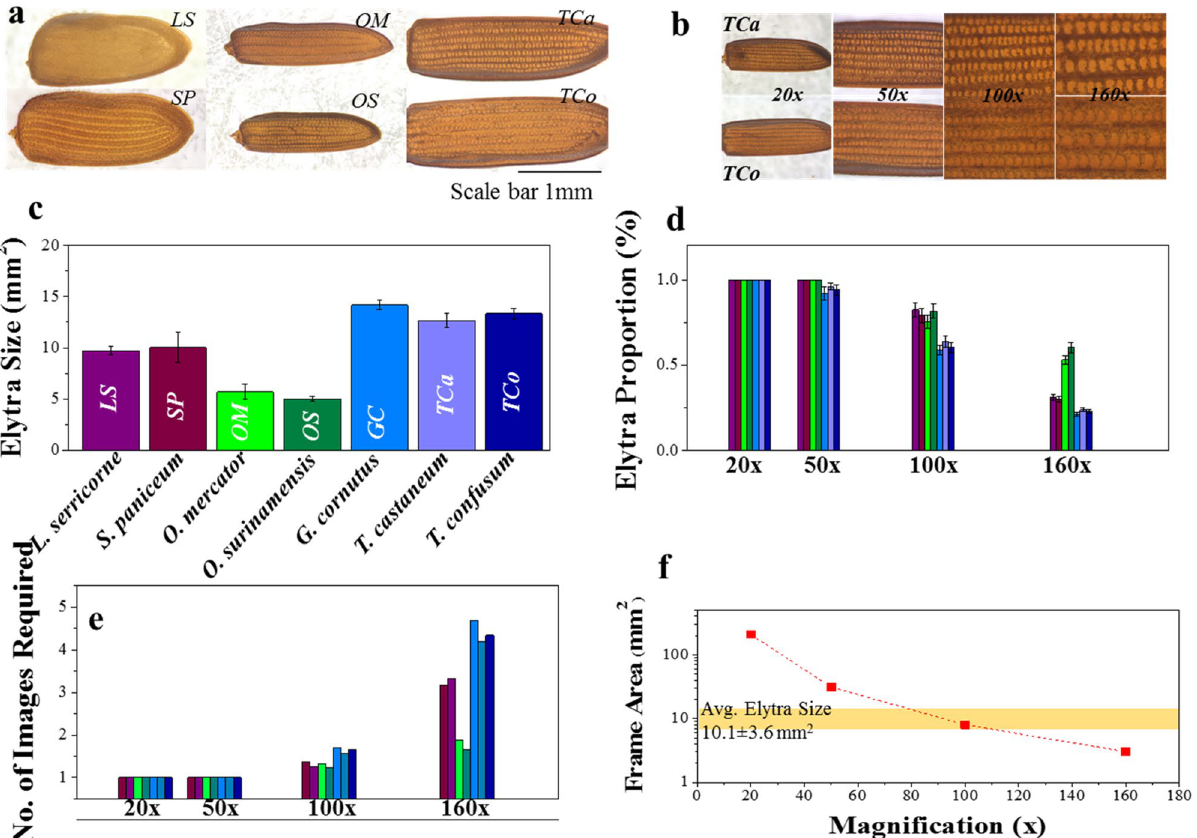
Figure 4. Magnification considerations: (a) Elytra images captured at 50 × magnification, showing their overall appearance; (b) Elytra images of T. castaneum ( TCa ) and T. confusum ( TCo ) at various magnifications showing area of elytra captured in each frame/magnification, (c) variation in average elytra sizes (of 10 images per species) for the seven different species used in this study, (d) proportion (area imaged/total area) of elytra captured at various magnifications, (e) number of images required (elytra size/frame size) to visually represent the whole elytra and (f) change in frame area (area captured in an image) by magnification. Even though there is a variation in elytral sizes, collectively they can be represented effectively at a magnification of 100